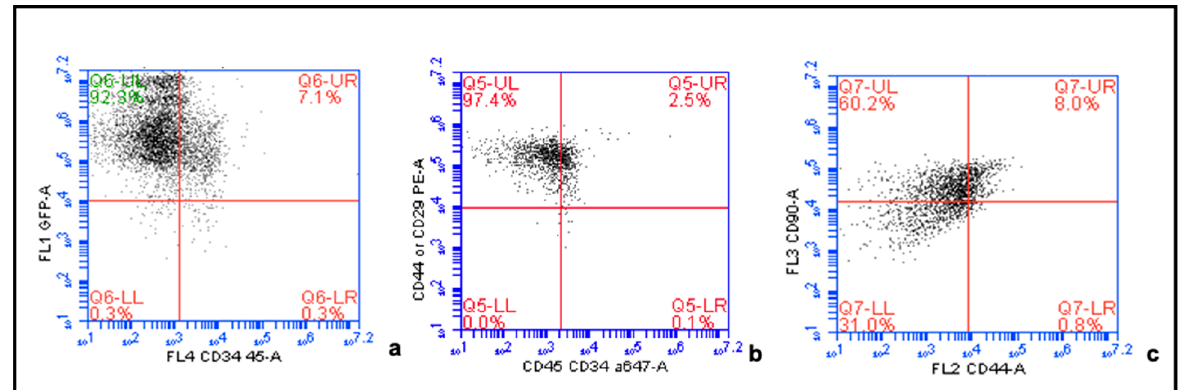
Figure A2. Flow cytometry of extracted MSCs to confirm MSC phenotype. Results of Flow cytometry for MSCs after staining for the surface markers CD29, CD34, CD44, CD45 and CD90. GFP positivity was confirmed by gating for GFP and 92% of those MSCs were negative for CD34 and CD45 ( a ). 97% of all MSCs were positive for CD44 or CD29 whilst being negative for CD45 and CD34 ( b ). 60% of all MSCs were furthermore positive for CD90 and CD44 ( c ).